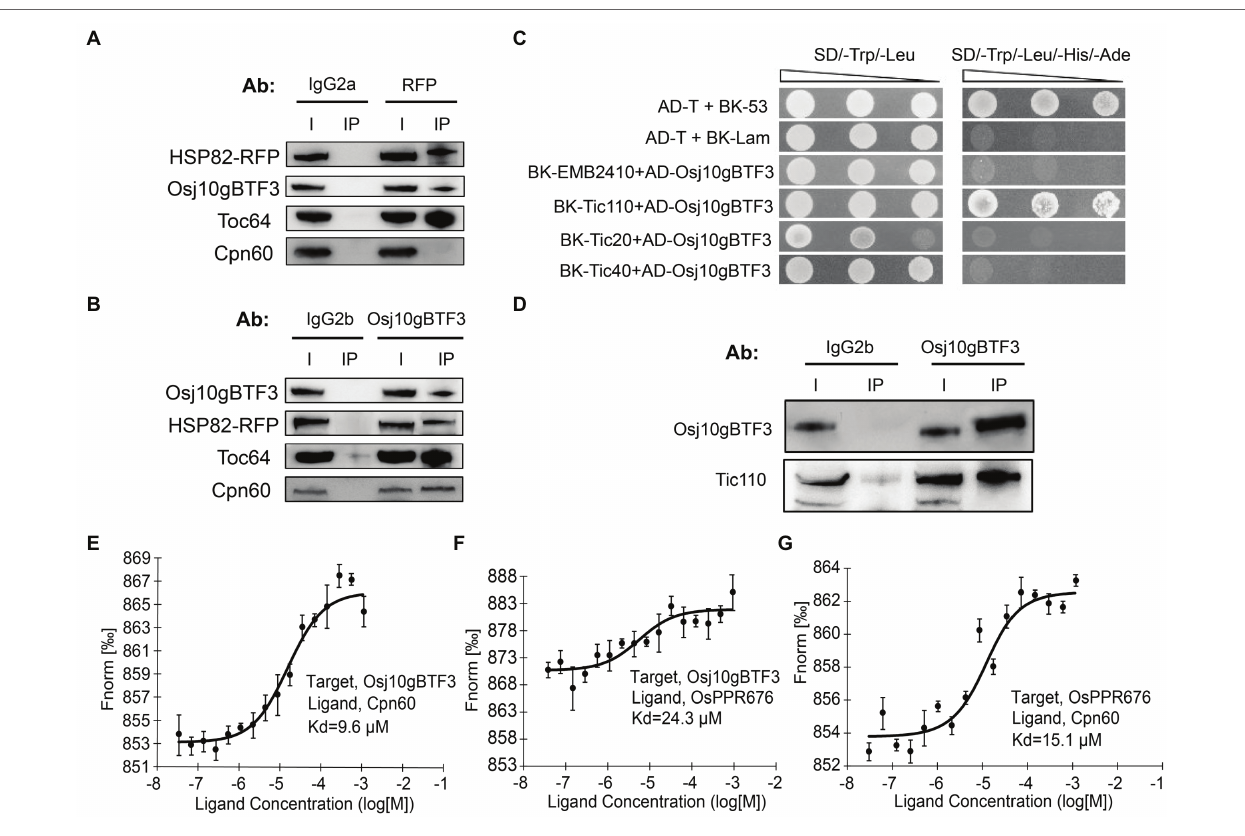
FIGURE 6 | Osj10gBTF3 enters the chloroplast stroma and recruits OsCpn60 to OsPPR676. (A) and (B) Co-IP analysis of OsHSP82 (A) or Osj10gBTF3 (B) and Toc64 or Cpn60 by corresponding antibodies. Co-precipitated proteins were identified by Western blotting. The IgG2a and IgG2b were used as isotype control for RFP and Osj10gBTF3 antibodies, respectively. Ab, antibody; I, input; and IP, immunoprecipitation. Three independent replicates were performed for each experiment. (C) Analysis of the interaction between Osj10gBTF3 and the presumed channel proteins at the inner membrane of chloroplast. The pGADT7-T cells co-transformed with pGBKT7-53 or the pGBKT7-Lam were used as positive or negative controls, respectively. Three independent replicates were performed for the experiment. (D) Co-IP verification analysis of the interaction between Osj10gBTF3 and chloroplast inner membrane protein Tic110. The proteins were extracted from leaves of rice wild-type seedlings. The input is 1/4 of total loading lysate. IgG2b were used as isotype control for Osj10gBTF3 antibodies. I, input; IP, immunoprecipitation. Three independent replicates were performed for the experiment. (E–G) MST was performed to determine the equilibrium dissociation constants ( K d ) between Osj10gBTF3, OsCpn60, and OsPPR676. Values represent the mean ± SD, n = 3 independent